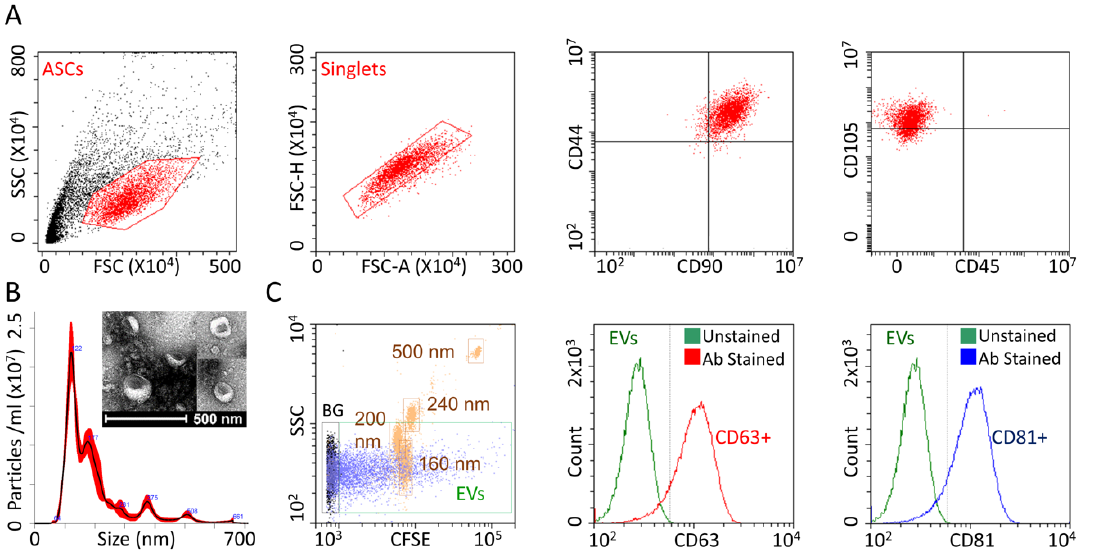
Figure 2. ASC and ASC-EV phenotype. ( A ) After FSC / SSC gating and singlets definition, ASCs resulted positive for CD90 / 44 / 105 MSC markers and negative for CD45 determinant. Representative cytograms of a single population are shown. ( B ) The size distribution of nanoparticles by NanoSight particle-tracking analysis and transmission electron micrographs of ASC-EVs showing particles with characteristic cup-shapedmorphology( C )ThefirstpanelshowsthemergedcytogramsofFITC-fluorescentnanometric beads (160 nM, 200 nM, 240 nM and 500 nM, squared in brown) used for flow cytometer calibration and CFSE-fluorescently labeled ASC-EVs (total population in violet, CFSE positive events squared in green as EVs), both gated with respect to PBS + CFSE background (total population in black and squared in black as BG), and confirmed instrument sensitivity to identify ASC-EVs as small as below 200 nm. Events gated in the EVs trace were used for assessing CD63 / 81 staining shown in the last two panels made by merging unstained and Ab stained (CD63 in red and CD81 in blue) CFSE-EVs cytograms. Both EV markers were detected on the majority of isolated ASC-EVs. One representative donor is